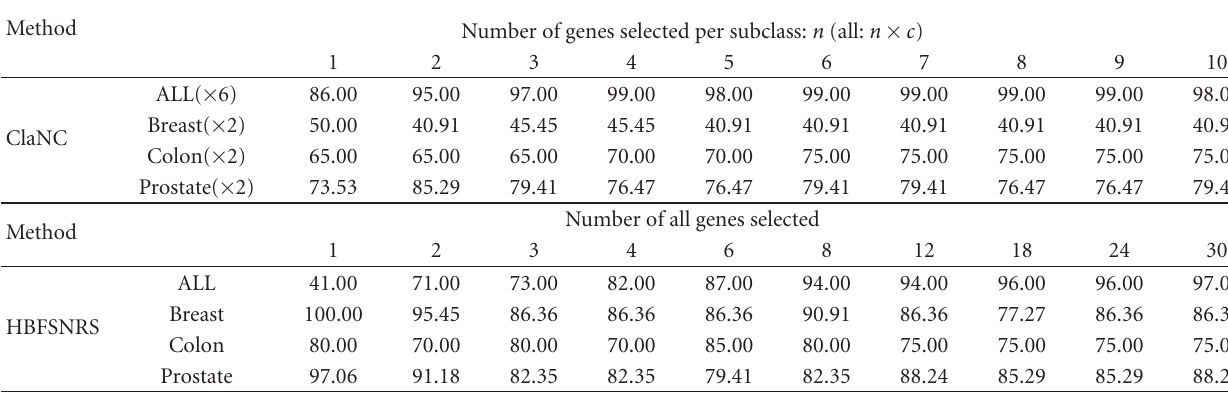
Table 3: The comparison with the ClaNC method in classification